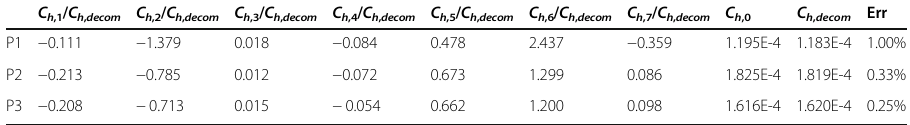
Table 3 Contributions of the terms in Eq.